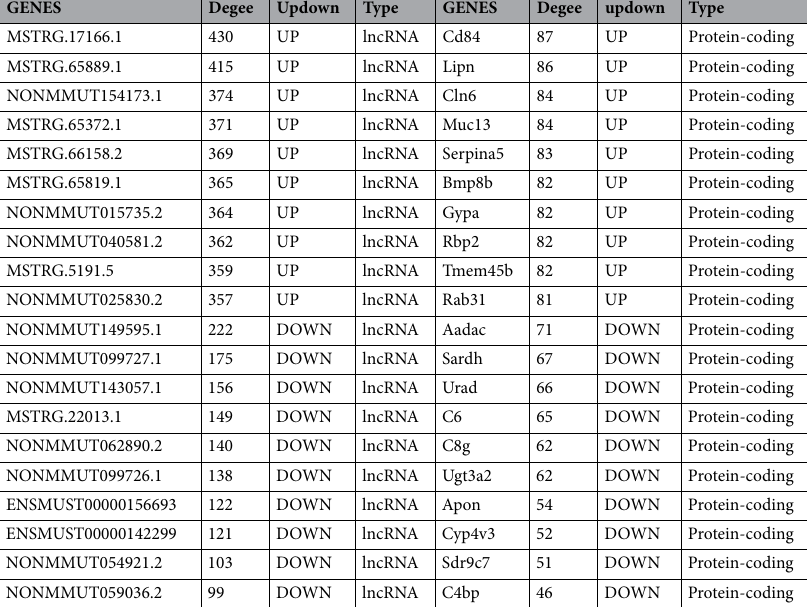
Table 3. Top10 connections of up- and down-regulated DELs and protein-coding genes in lncRNA-mRNA coexpression